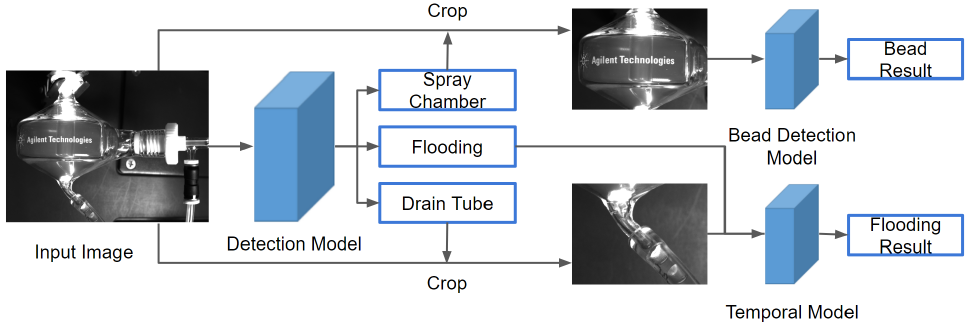
Figure 2. The whole pipeline of our method. We use an object detection model to obtain bounding boxes of the spray chamber, the drain tube, and flooding in an input image. Then we crop the spray chamber region and the drain tube region. Another detection model is applied to the spray chamber region for bead detection. We use a temporal model on a series of drain tube region images and confidence scores of the flooding bounding box to detect flooding.